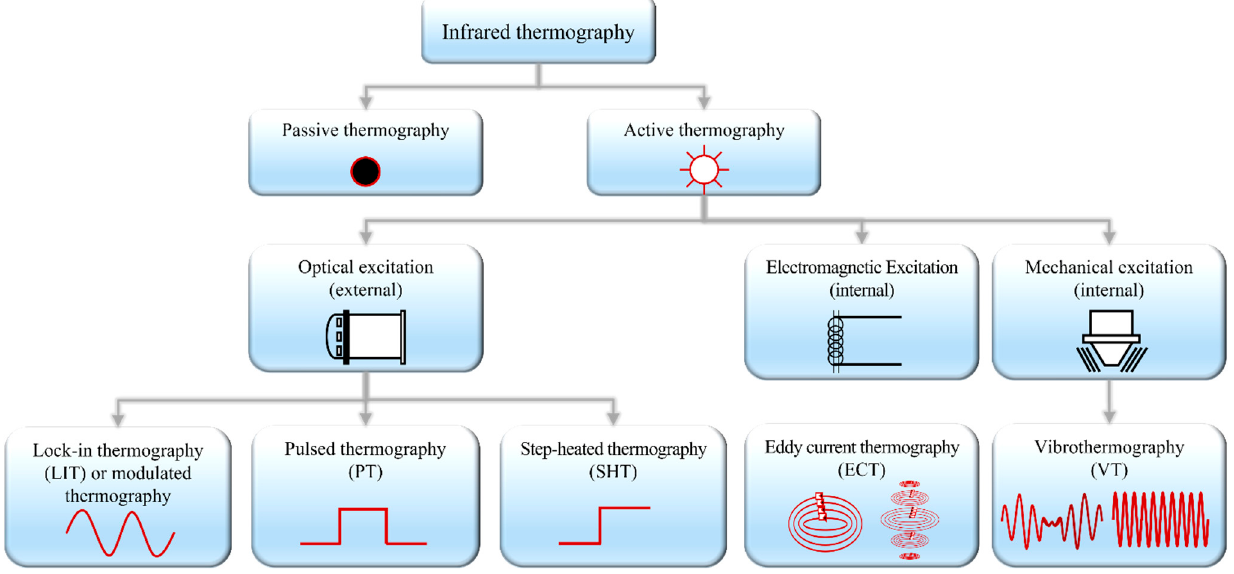
Figure 1. Classification of i nfrared thermographic testing approaches.